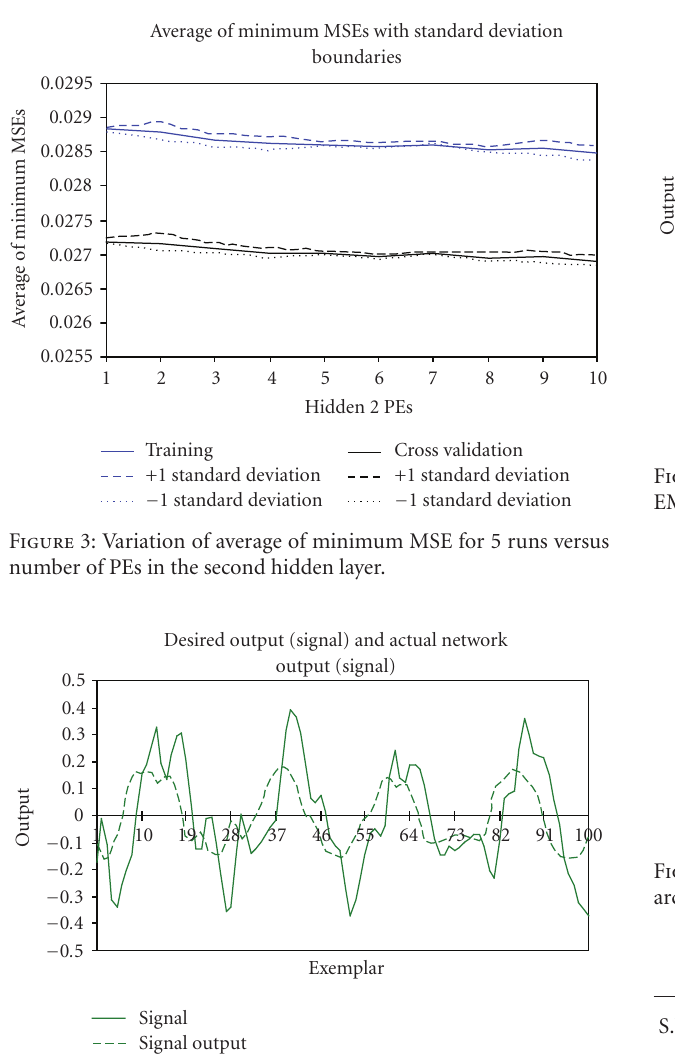
Figure 4: Modeling capability of MLP NN on testing dataset for EMG signal.